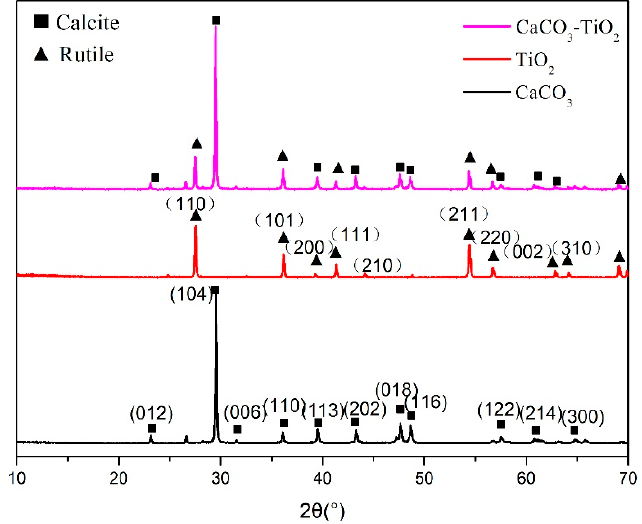
Figure 2. X-ray diffractometer (XRD) patterns of CaCO 3 , TiO 2 , and CaCO 3 -TiO 2 composite particles.